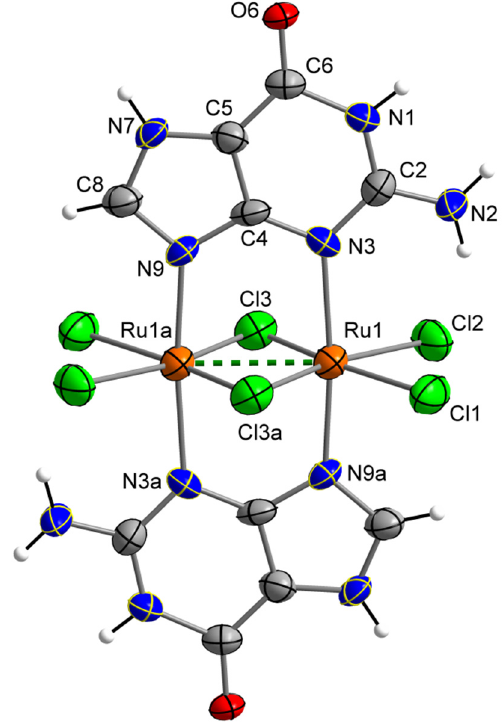
Figure 1. Molecular structure of the neutral [{Ru( µ -Cl)( µ -gua)} 2 Cl 4 ] complex in 1 along with the atom labels scheme, the green-dashed line indicating a metal–metal bond. Water molecules have been omitted for clarity.